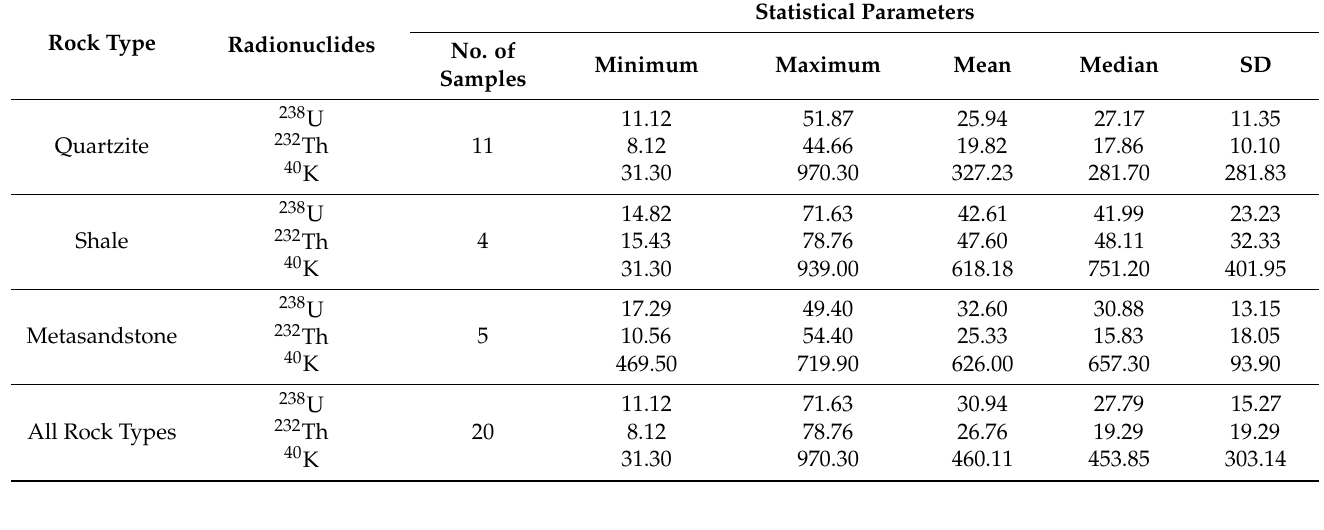
Table 2. In situ activity concentration of 238 U, 232 Th, and 40 K in different rock types of the West Rand and East Rand areas.